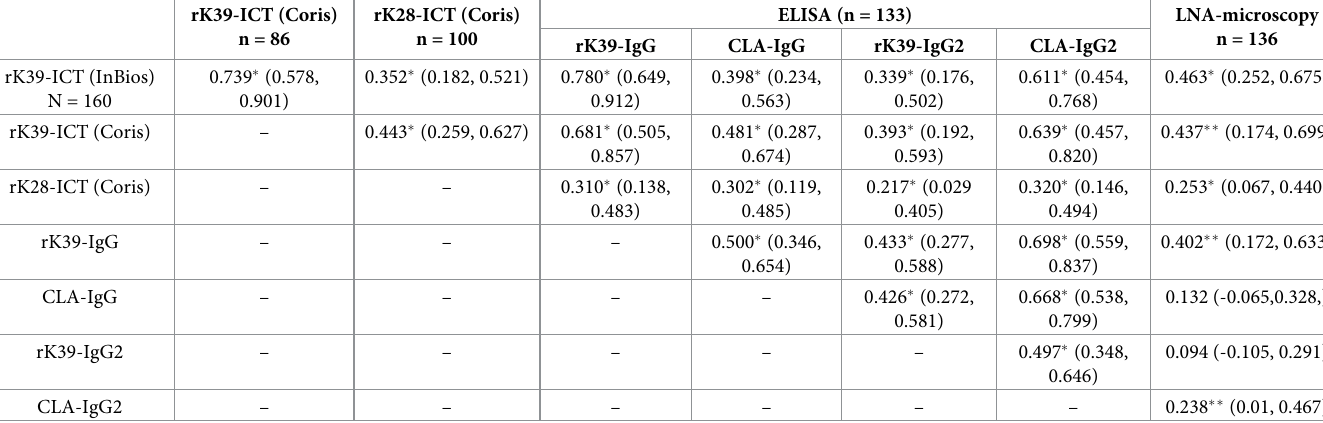
Table 2. Estimated concordance between diagnostic tests by Cohen’s kappa coefficient (95% confidence intervals). � p < 0.01, �� p < 0.05 by t-test. rK39-ICT (Coris) n = 86